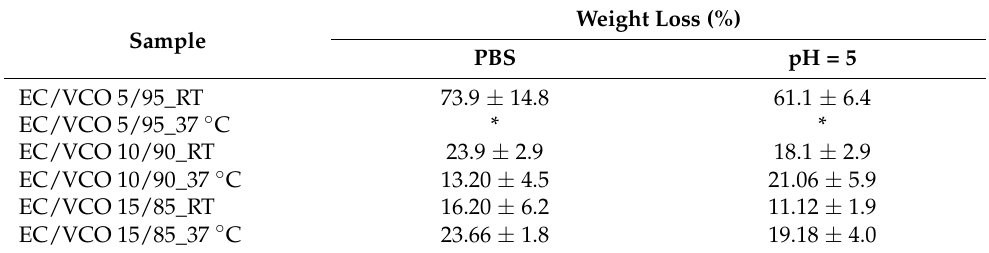
Table 3. Weight loss of the oleogel samples after immersion in PBS and pH = 5 up to 28